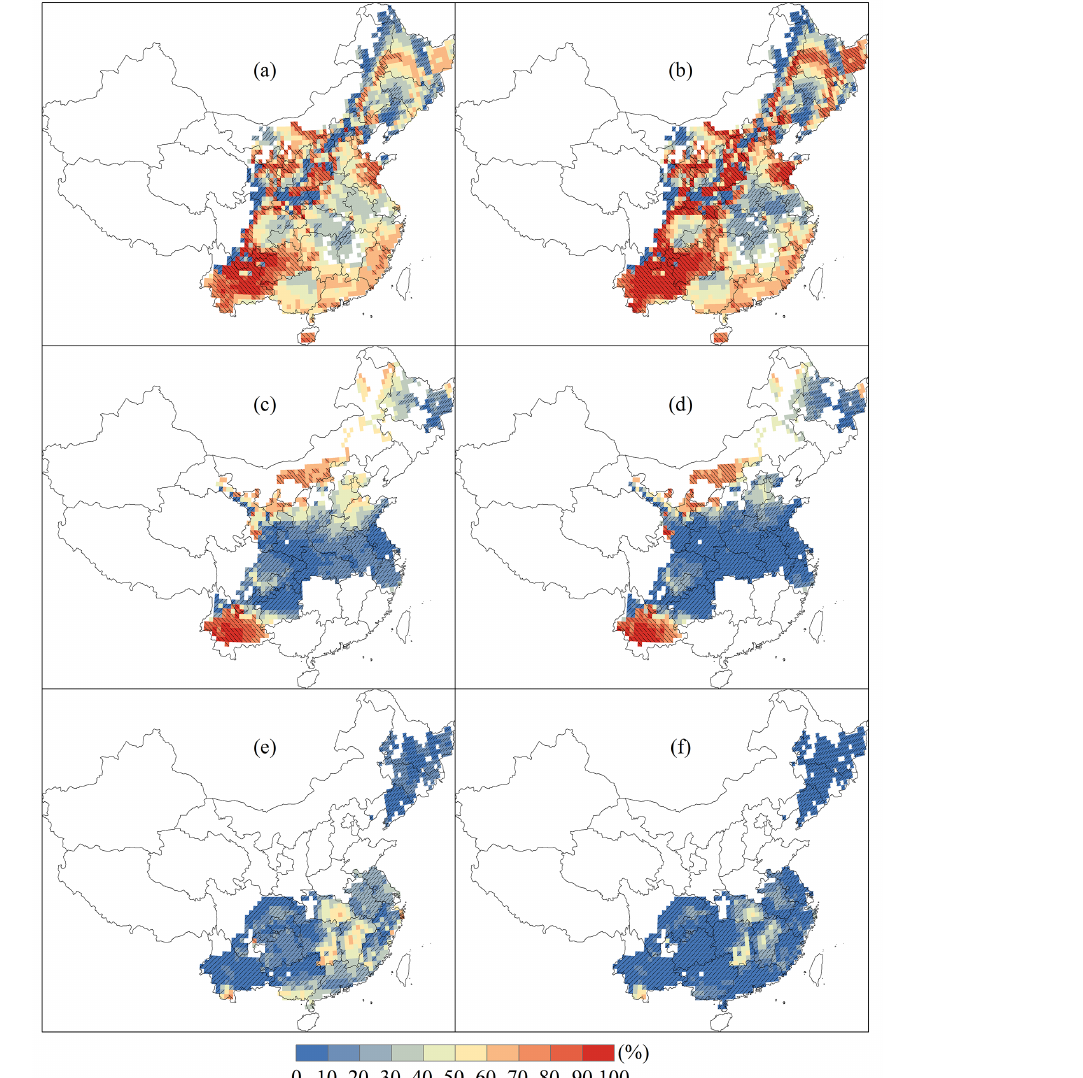
Figure 10. Median of projected yield decrease probability for maize (a, b) , wheat (c, d) and rice (e, f) during 2106–2115 under the 1.5 ◦ C warming (a, c, e) and 2.0 ◦ C warming (b, d, f) scenarios, taking the CO 2 fertilization effect into account. Hatching indicates the areas where more than 70% of the ensemble simulations agree on the sign of yield